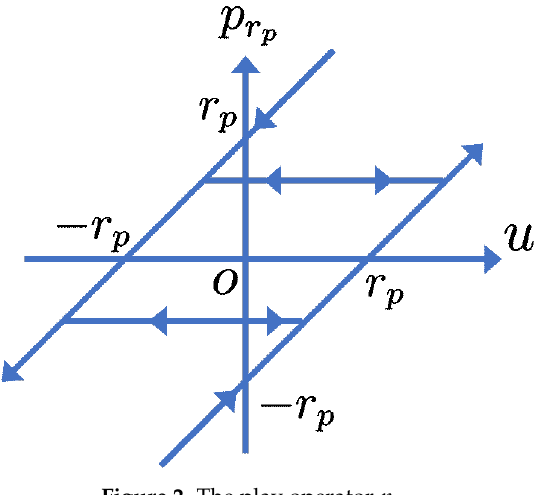
Figure 2. The play operator p r